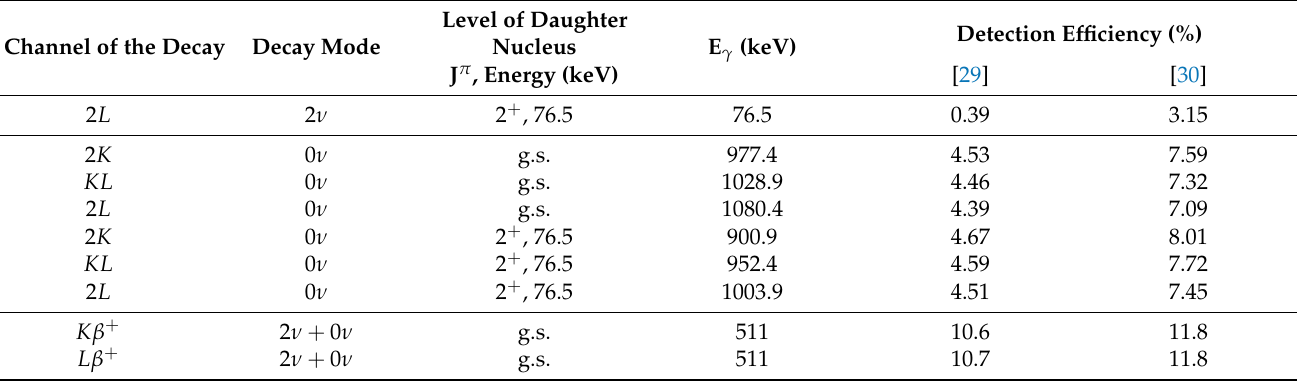
Table 1. The detection efficiency of some 2 (cid:101) and (cid:101)β + processes in 174 Hf as performed in Refs. [29,30] if comparable. E γ is the γ quanta used in both the experiments to study the half-life of the related transition.